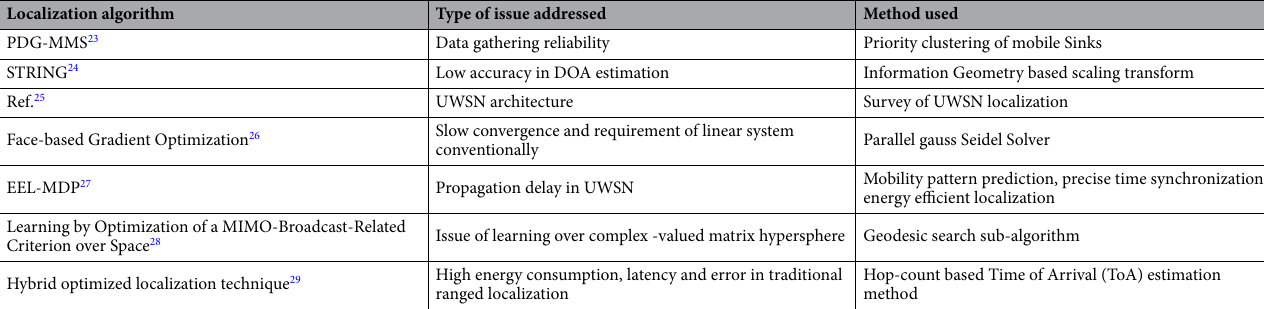
Table 1. Latest UWSN localization and geodesic works in